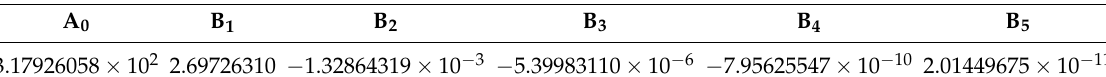
Table 1. Factory determined spectral resolution coefficients for the C12880MA sensor SN17I00621.